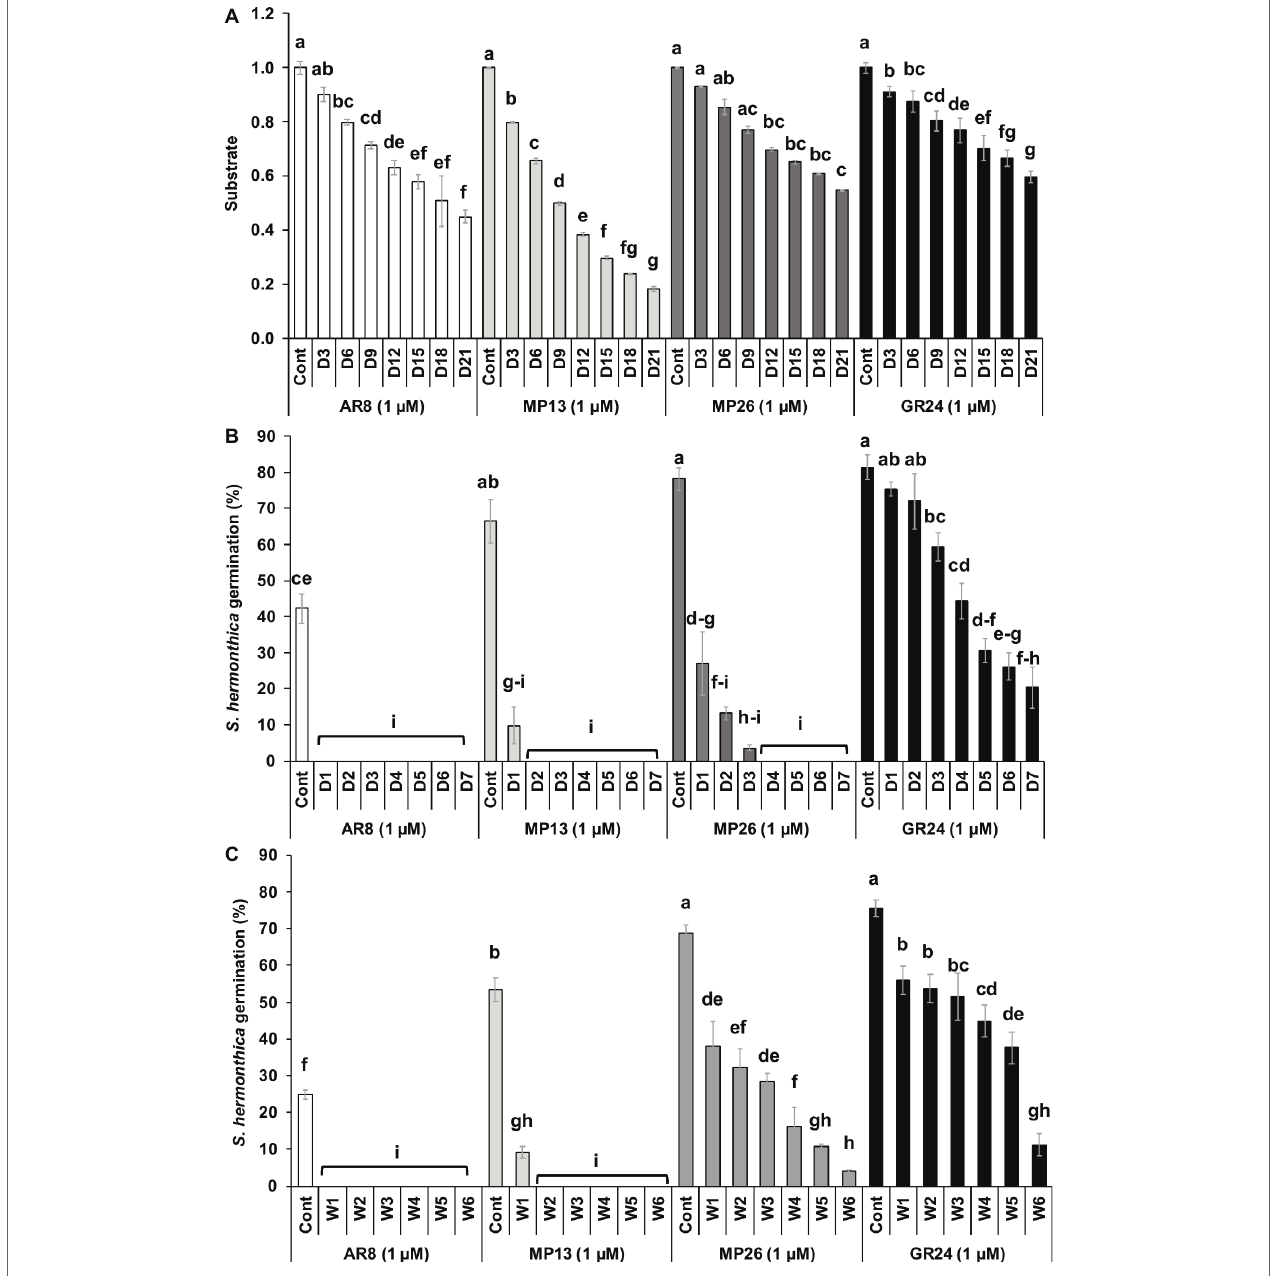
FIGURE 5 | (A) Stability of SL analogs by HPLC analysis. The relative amount of non-degraded analogs was monitored in HPLC at 3 days’ interval up to 3 weeks and determined by comparison with internal standard. Data are means ± SE ( n = 3). X-axis: time (days); Y-axis: substrate. (B) Stability of formulated SL analogs in sand. The formulated SL analogs were incubated at 30 ° C in sand daily up to 7 days. Striga germination was counted from each disc treated with SL analogs from respective days. (C) Stability of formulated SL analogs in aqueous solution. The formulated SL analogs were incubated at 30 ° C in aqueous solution weekly up to 6 weeks. Striga germination was counted from each disc treated with SL analogs from respective weeks. Data are means ± SE ( n = 3) and compared by one-way ANOVA. Means not sharing a letter in common differ significantly at p 0.05